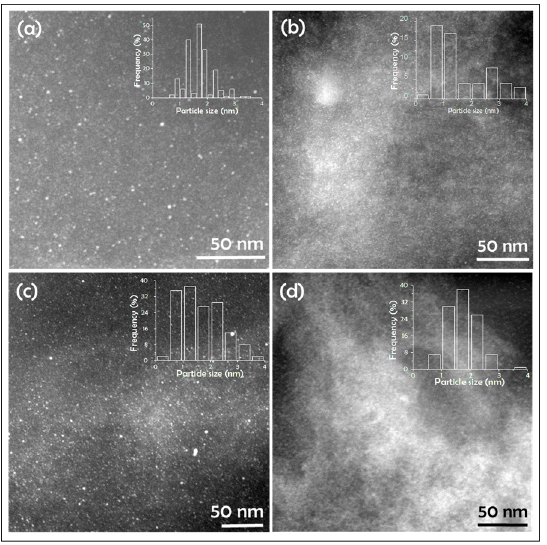
Figure 2. Dark-Field Scanning Transmission Electron Microscopy (DF-STEM) images of ( a ) Pd/CS, ( b ) Pd/CS-GO1, ( c ) Pd/CS-GO2, and ( d ) Pd/CS-GO3. The insets show the histograms of corresponding particle size distribution.